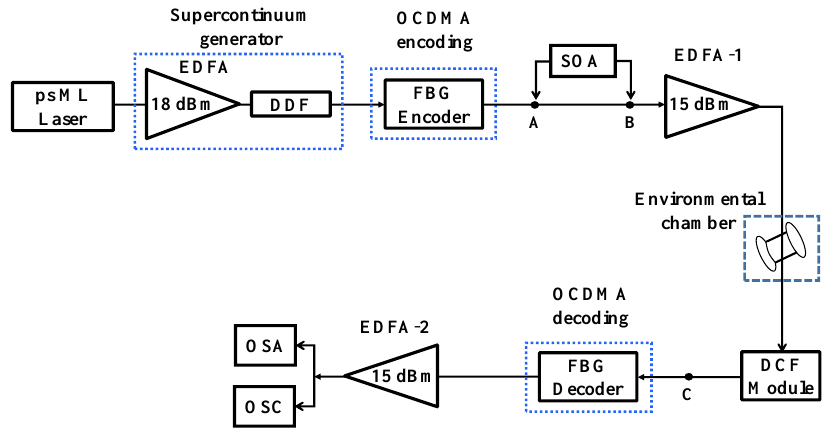
Figure 1. Experimental setup for the chirp control investigation by SOA at a transmitter site. ps ML Laser: picosecond mode locked laser; EDFA: erbium doped fibre amplifier; DDF: dispersion decreasing fibre; FBG: fibre Bragg gratings; DCF: dispersion compensating fibre; SOA: semiconductor optical amplifier; OSA: optical spectrum analyser; OSC: oscilloscope.